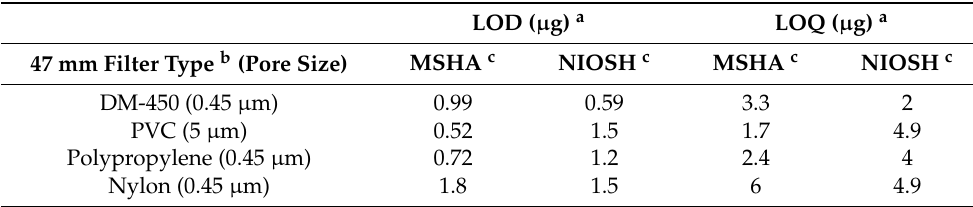
Table 5. Limits of detection (LOD) and limits of quantification (LOQ) for membrane filters analyzed by FTIR [52]. LOD ( µ g) a LOQ ( µ g) a 47 mm Filter Type b (Pore